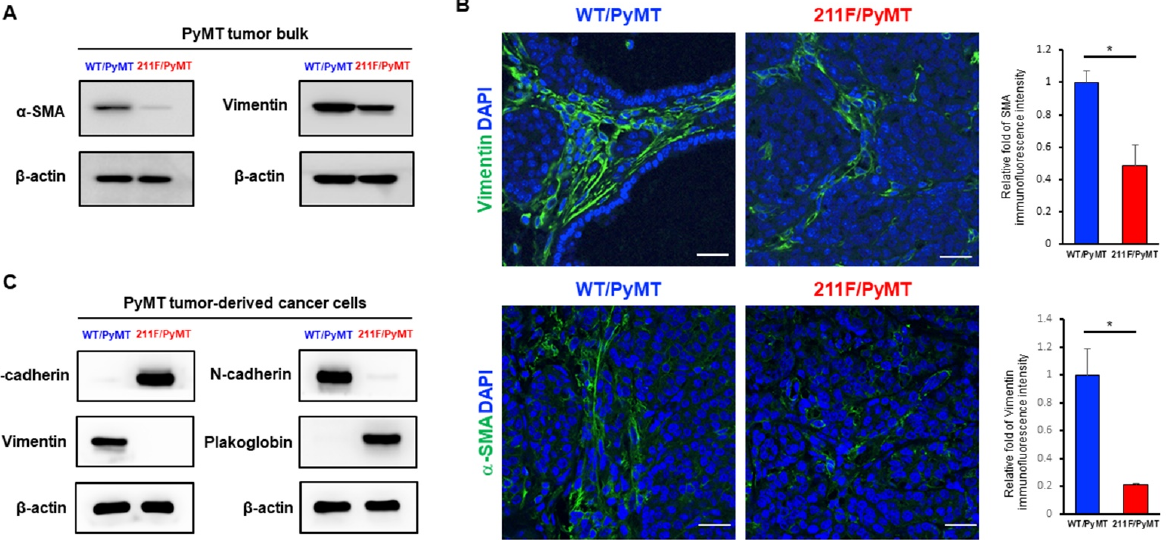
Figure 1. Enhanced mesenchymal phenotype in spontaneous tumors derived from WT/PyMT mice but not in tumors developed in 211F/PyMT mice. ( A ), Protein extracts were prepared from the tumors isolated from 10-week-old MMTV/PyMT mice of the indicated strains; expression of vimentin, SMA and the internal control β -actin was characterized by immunoblotting. ( B ), Immunofluorescence staining of vimentin and α -SMA in PyMT tumor tissues of the indicated strains. Representative images of immunofluorescence staining are shown. Bar, 25 µ m. Vimentin and α -SMA expression in the PyMT cells was quantitated by ImageJ. The relative fold changes were calculated by the staining ratios of FITC to DAPI. Bar, standard deviation. *, p < 0.05 by Student’s t -test. ( C ), Western blotting analysis of the indicated EMT markers in WT and Y211F PyMT tumor-derived cells.